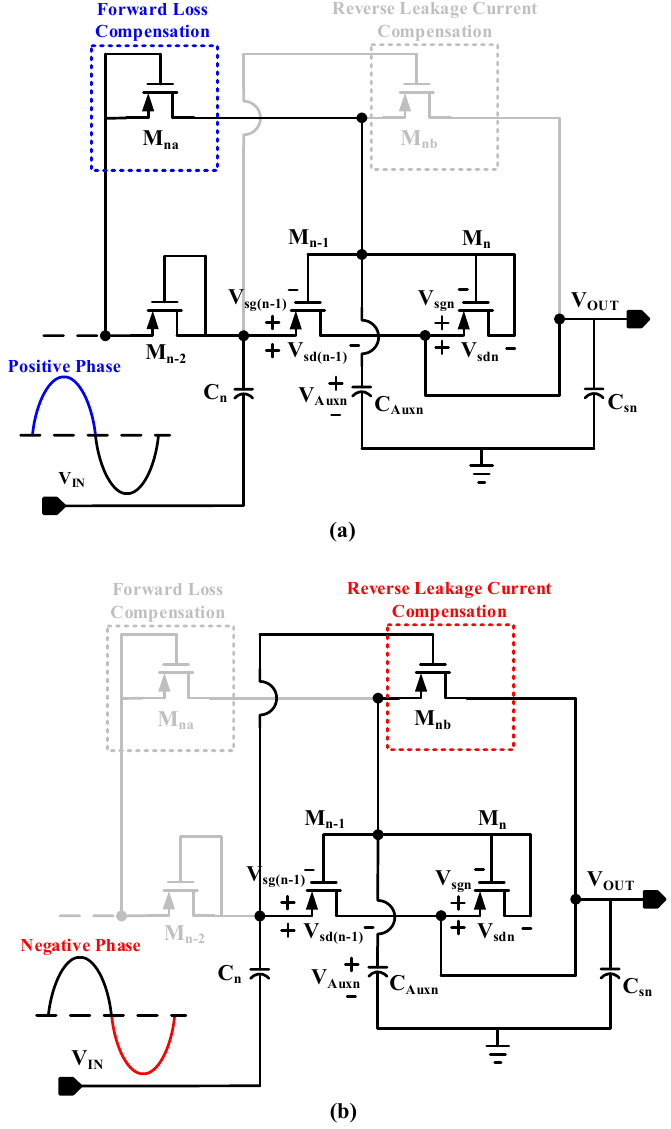
Figure 7. Operation of the proposed scheme during ( a ) positive phase and ( b ) negative phase.